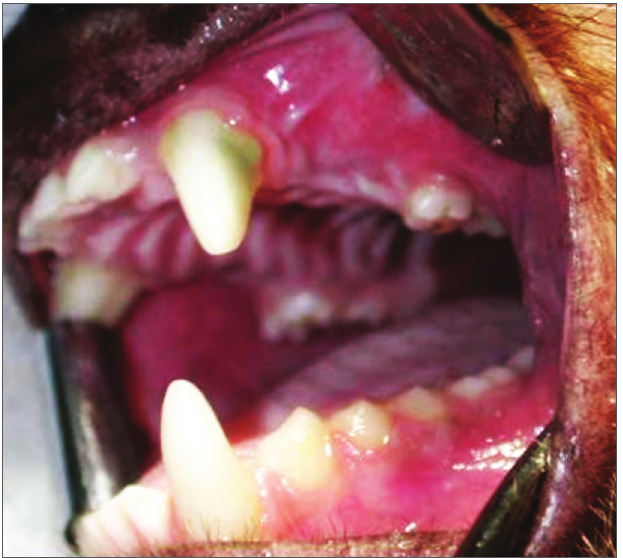
Figure 2. Three months after the first surgery - alveolar repair phase.